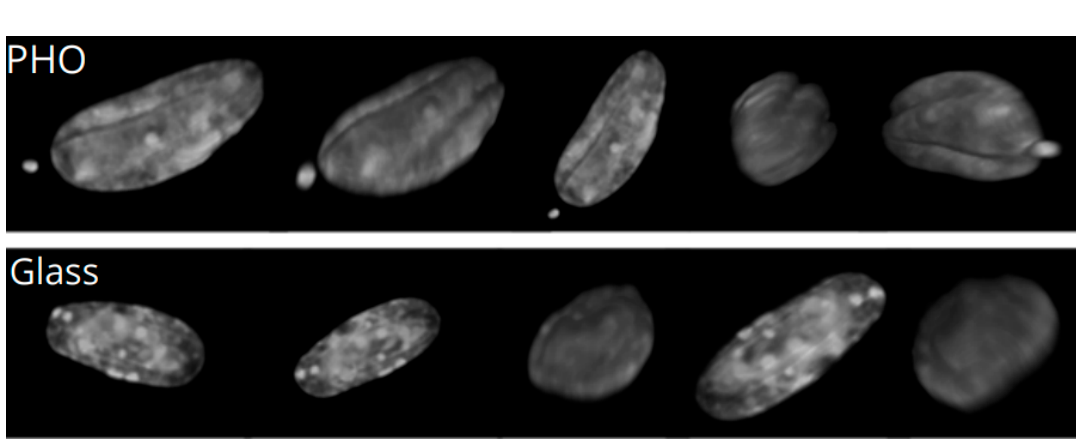
Figure 5. Example of 3D nucleus reconstruction for selected cells with grooves.